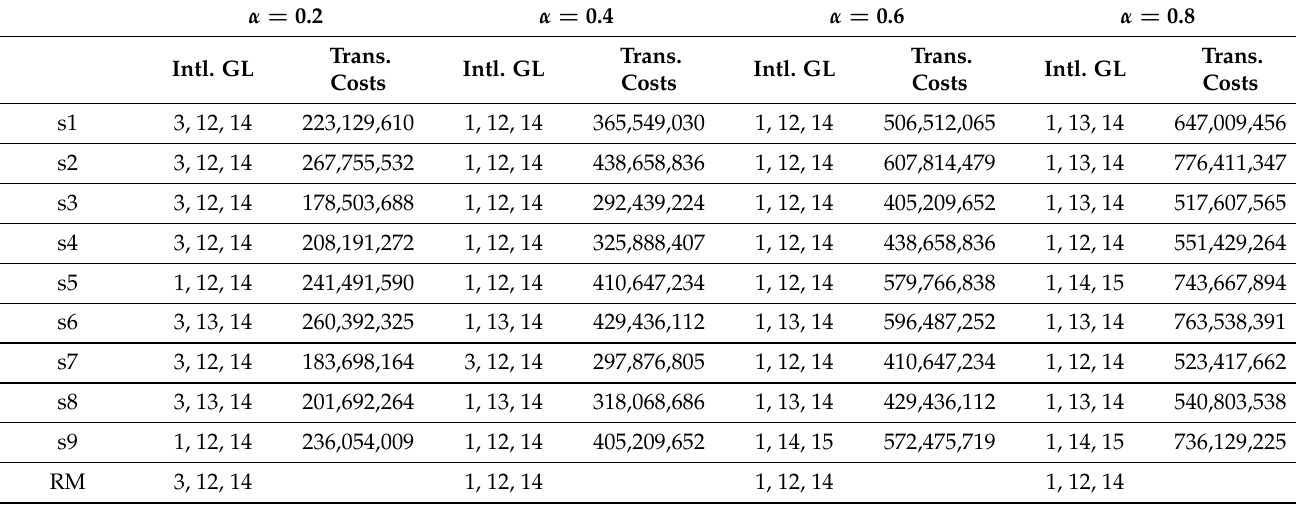
Table 4. Results with the uncertain unit transportation